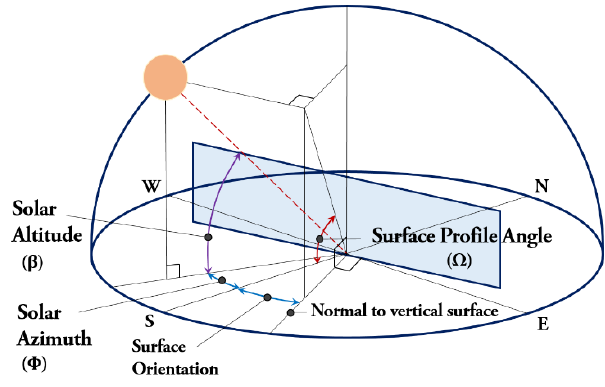
Figure 2. Concepts of the solar azimuth and altitude.